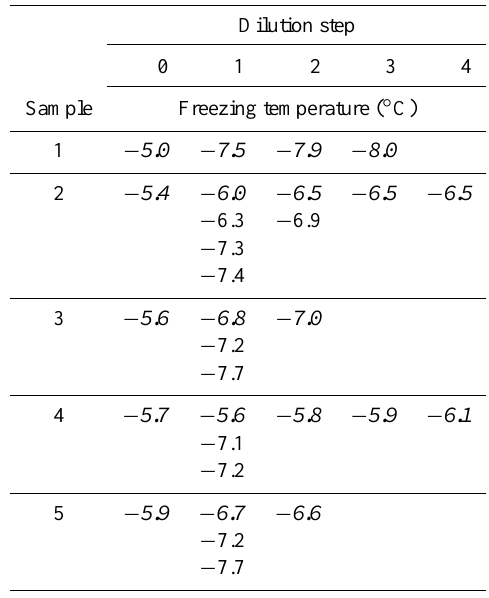
Table 2. Freezing temperatures of five samples (200µL each of the same snow water) repeatedly diluted (1 : 10 with 0.9% NaCl) and split into ten portions each. A freeze test was performed after the first dilution step and the freezing temperature is indicated for those of the ten sub-samples that froze at temperatures warmer than to − 8 ◦ C. Only the sub-sample with the warmest freezing temperature was taken to the next dilution step (marked in italic). Those freezing at colder temperatures were discarded. A total of 4 dilution steps were carried